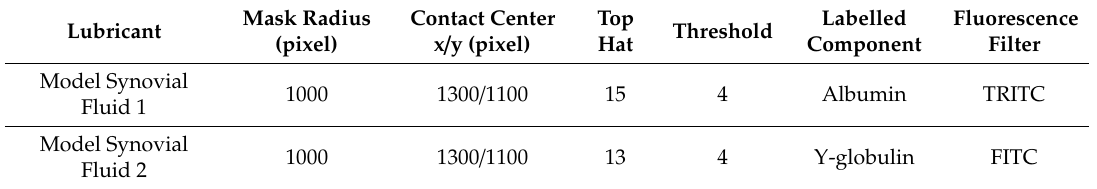
Figure 11. Comparison chart of individual input parameters. Table 3. Percentage deviation of CoF.